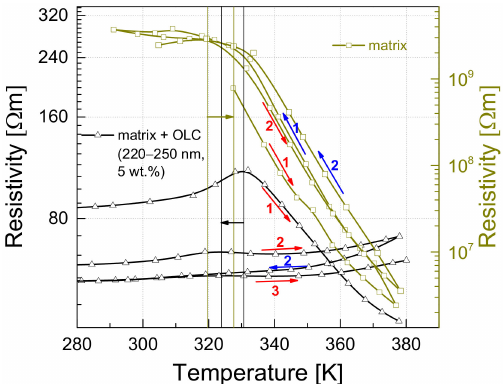
Figure 7. Dependence of the resistivity on the temperature for the composite with 5 wt.% of OLCs of size 220–250 nm and the epoxy resin with repeated cooling and heating cycles: red arrows indicate heating, blue arrows indicate cooling and the numbers near them indicate the cycle number. The vertical lines indicate the onset of noticeable changes in the structure, and the horizontal arrows indicate the direction of this onset point during the repetition of the cycles.